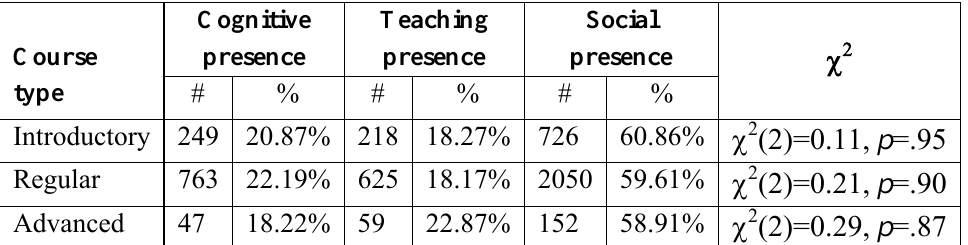
Table 12 Differences between Observed Distributions by Course Type and Proposed Population